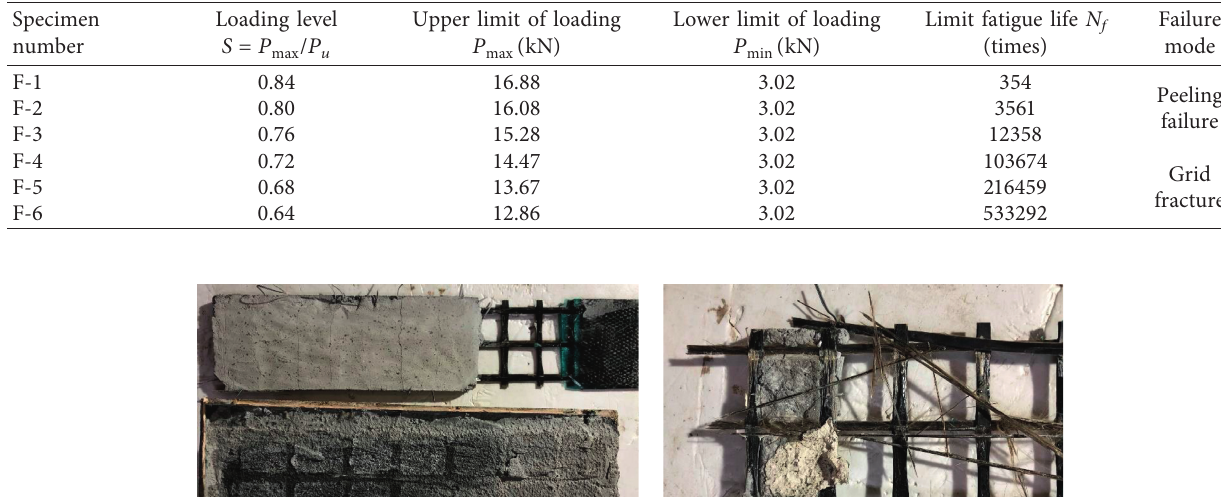
Figure 7: Loading-relative slip curve and failure mode of the BFRP grid under static loading. Table 1: Fatigue test results of BFRP grid-concrete interface.